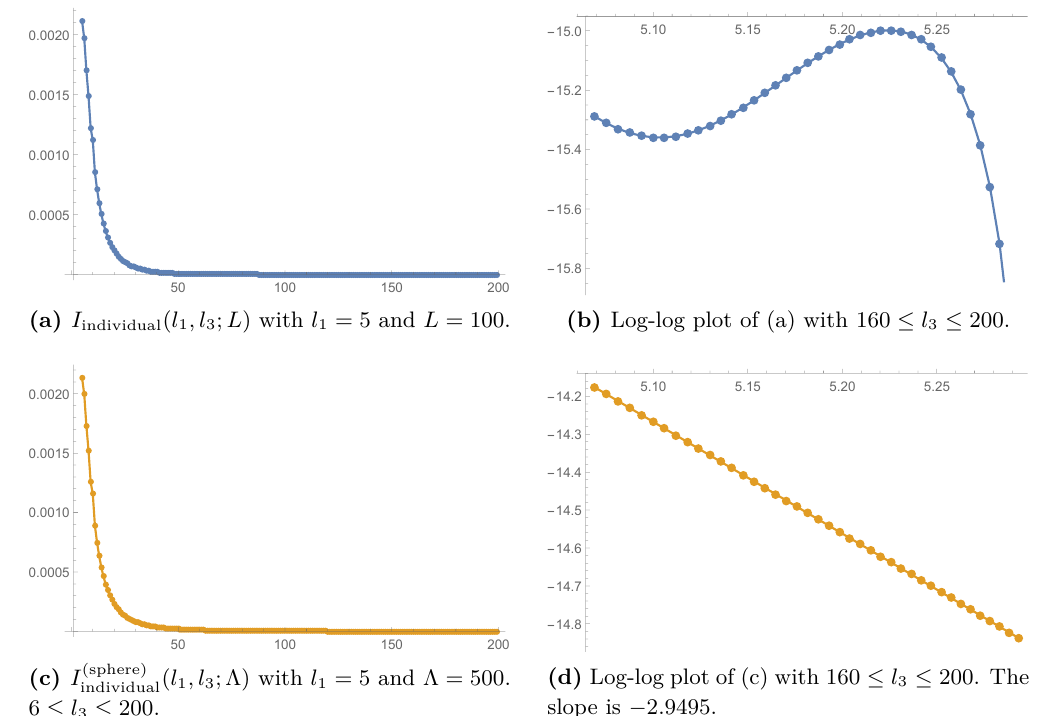
Figure 12 . The mutual information between two individual modes l ! and l 3 , I individual ( l 1 , l 3 ; Λ) . The horizontal axis is the larger momentum l 2 L = 200 and Λ = 500